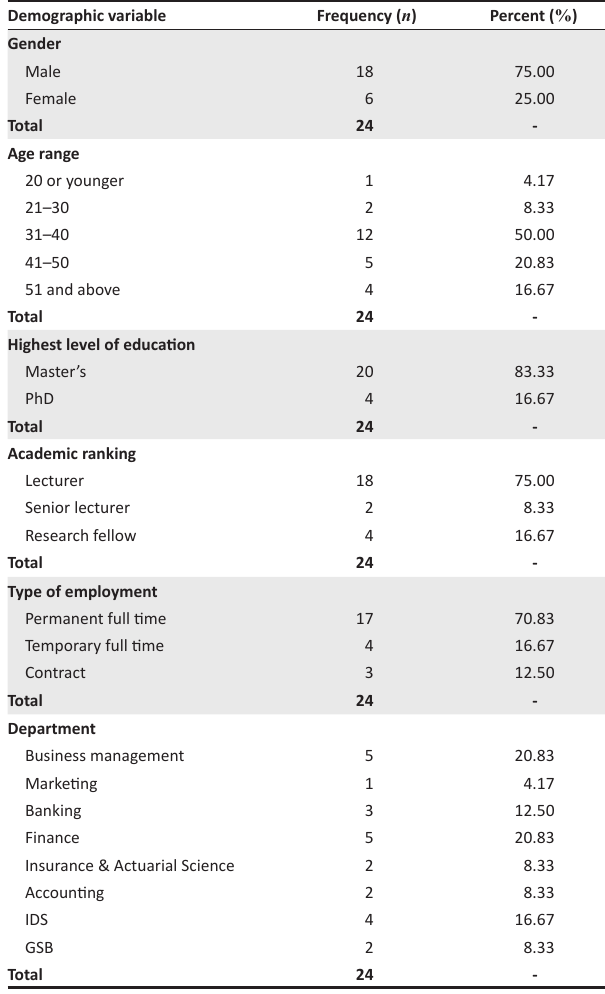
TABLE 1: Demographic composition of respondents who did studies on small and medium enterprises ( N =